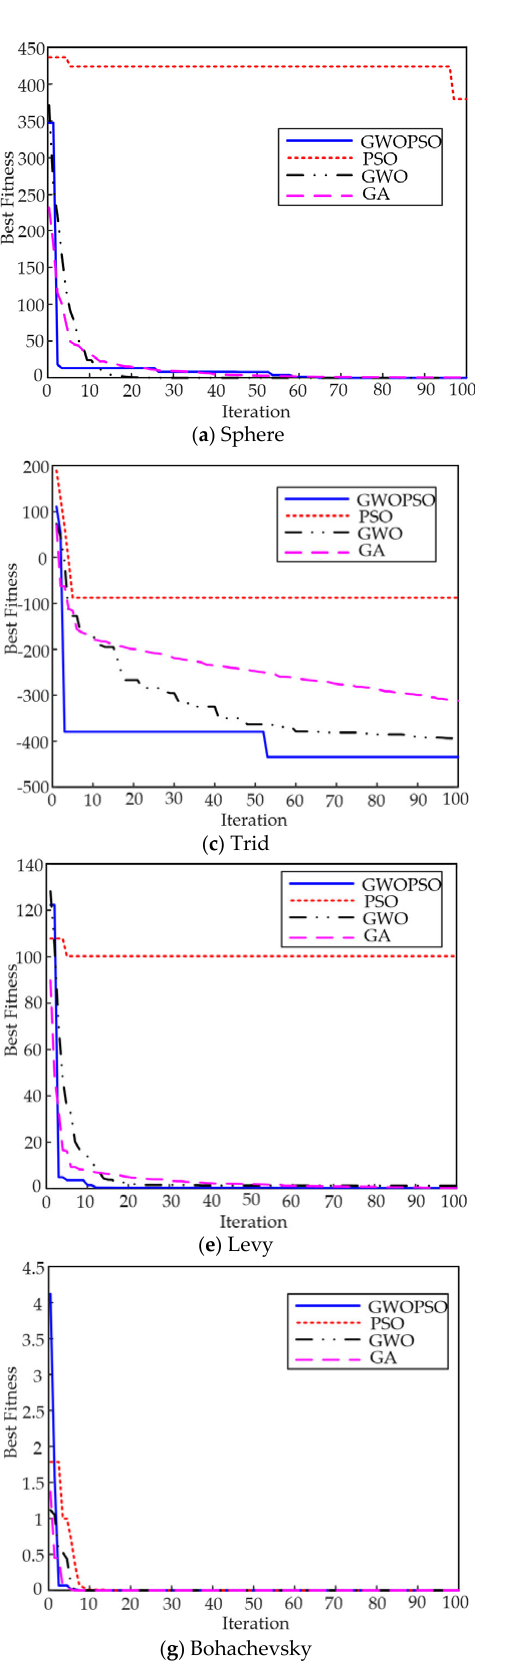
Figure 4. Convergence curves. The fitness mean and standard deviation in Table 5 reflect the convergence accuracy and stability of different algorithms under a given number of independent runs, respec- tively. The bold data in the table are the best test results. Figure 4 shows the optimal con- vergence curve of each algorithm on the benchmark function so that the constriction per- formance of the four methods may be compared intuitively. Through Table 5 and Figure 4, it is shown that on the unimodal function f 1 – f 4 , the GWOPSO algorithm maintains a high constriction rate from the beginning of the iteration and obtains the global optimum